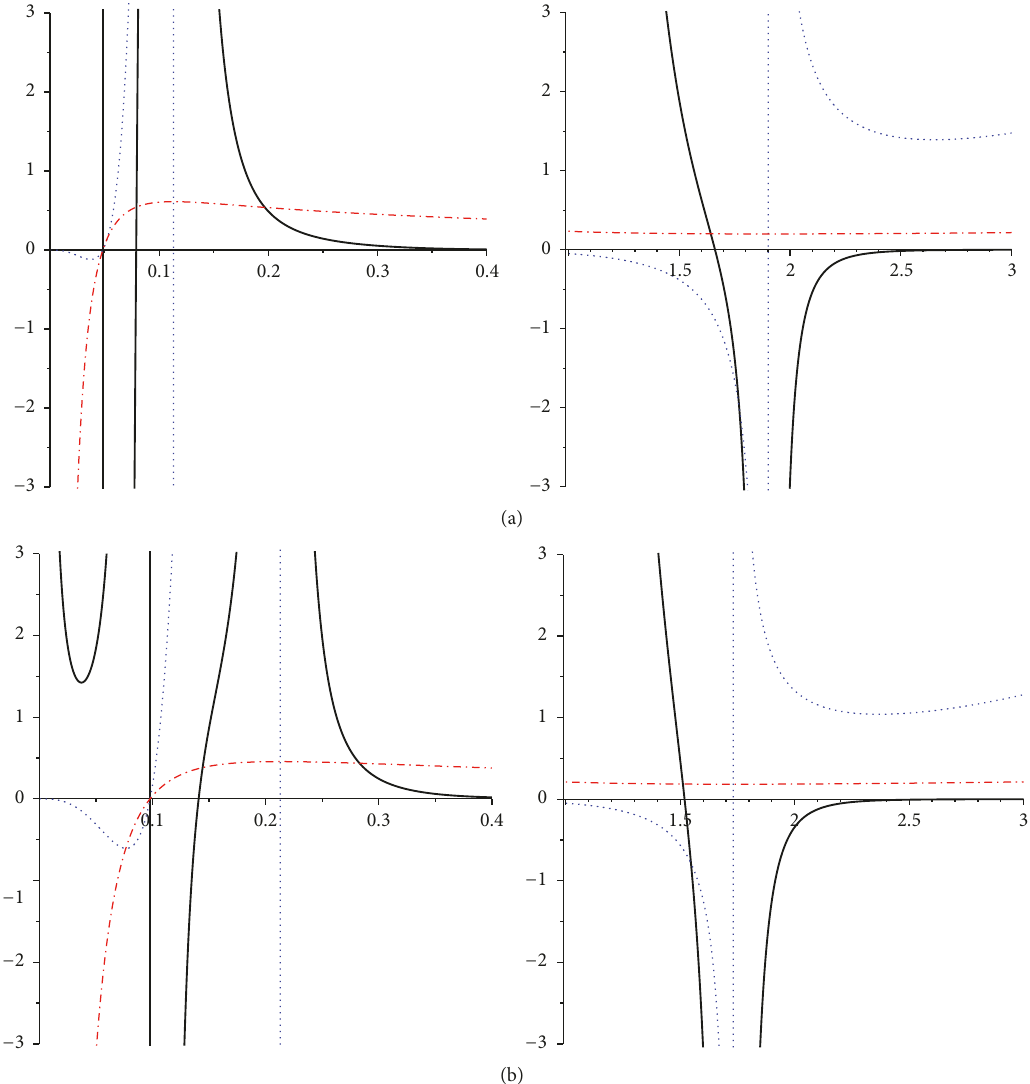
Figure 5: HPEM metric. R (continuous line), 𝐶 𝑄 (dotted line), and 𝑇 (dot dashed) versus 𝑟 + for Λ = −1 , 𝑛 = 4 , 𝑞 = 0.1 , 𝑏 = 1 , and 𝛽 = 1.5 . 𝜔 = 0.2 (a) and 𝜔 = 200 (b). “Note: both panels in the same line are plotted with the same parameters, but different regions.”